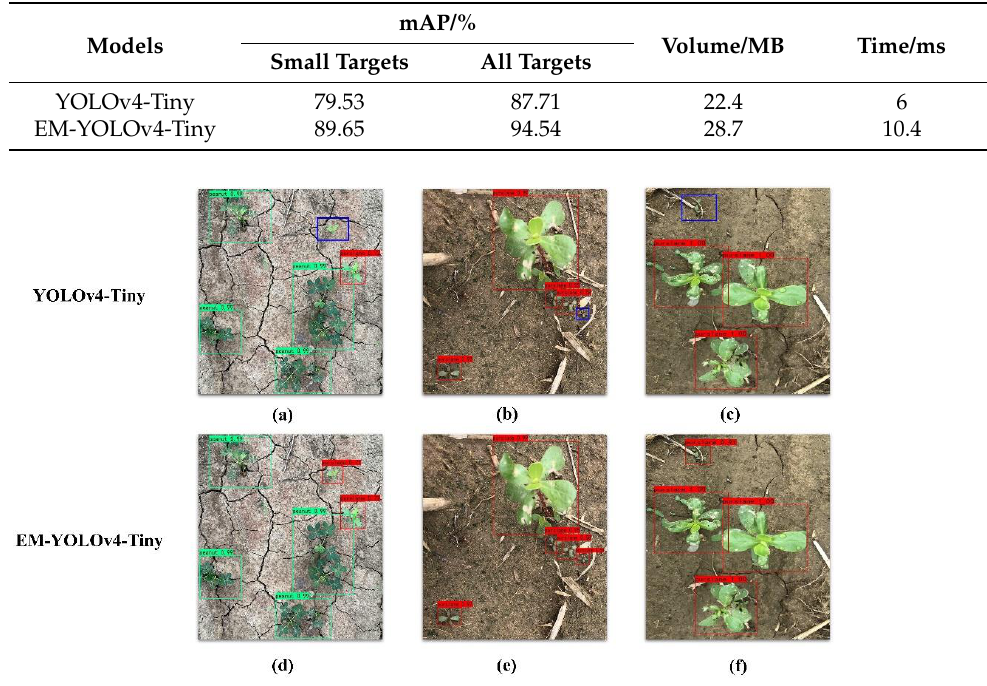
Table 3. Comparison of detection results of YOLOv4-Tiny and EM-YOLOv4-Tiny.